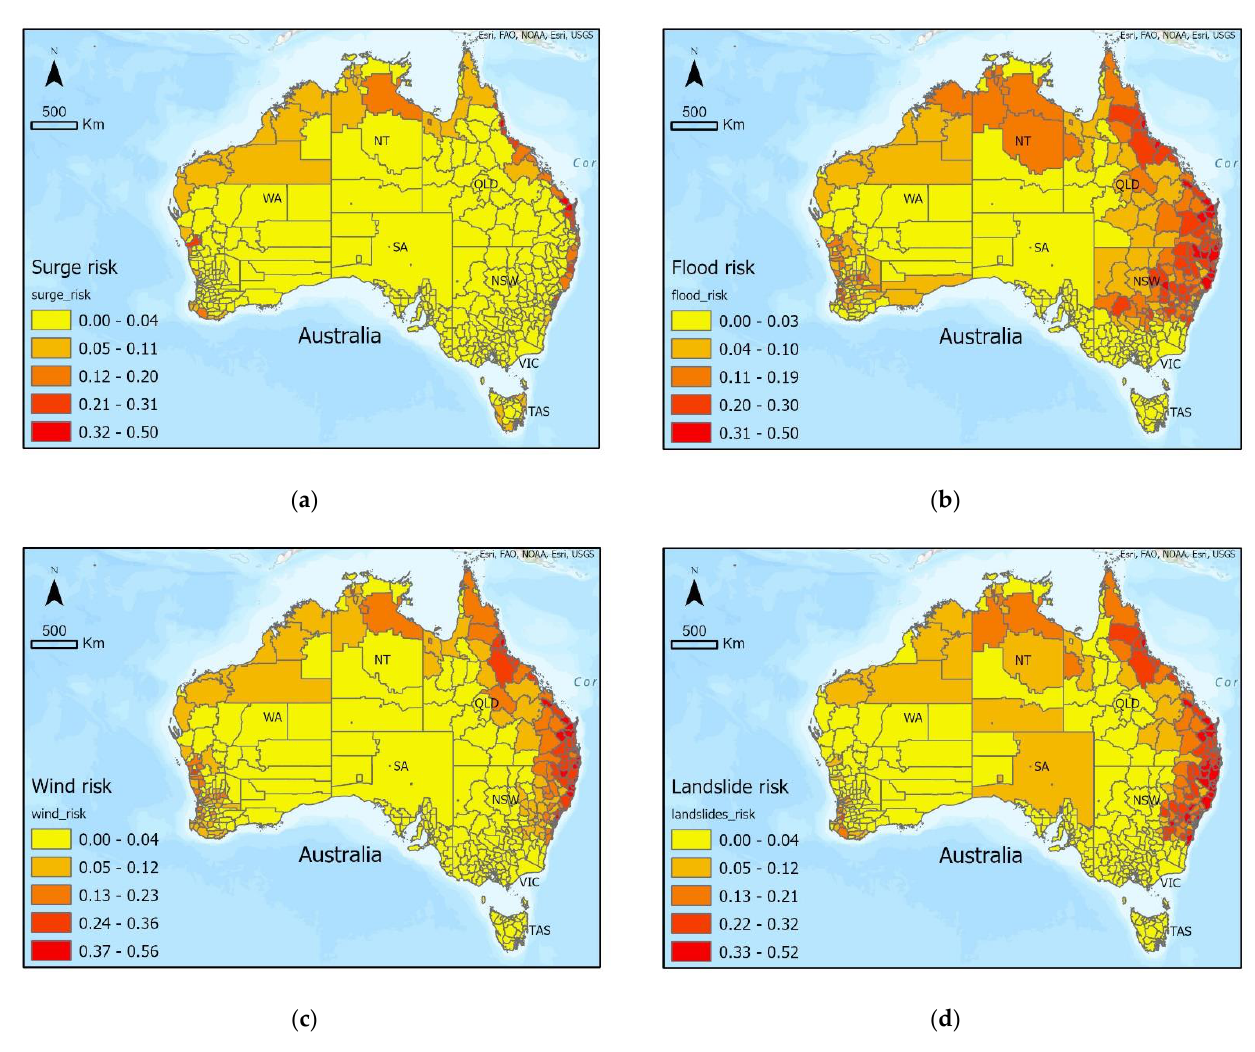
Figure 10. Hazard-specific risk maps of TC storm surge ( a ), flood ( b ), wind ( c ) and landslide ( d ).